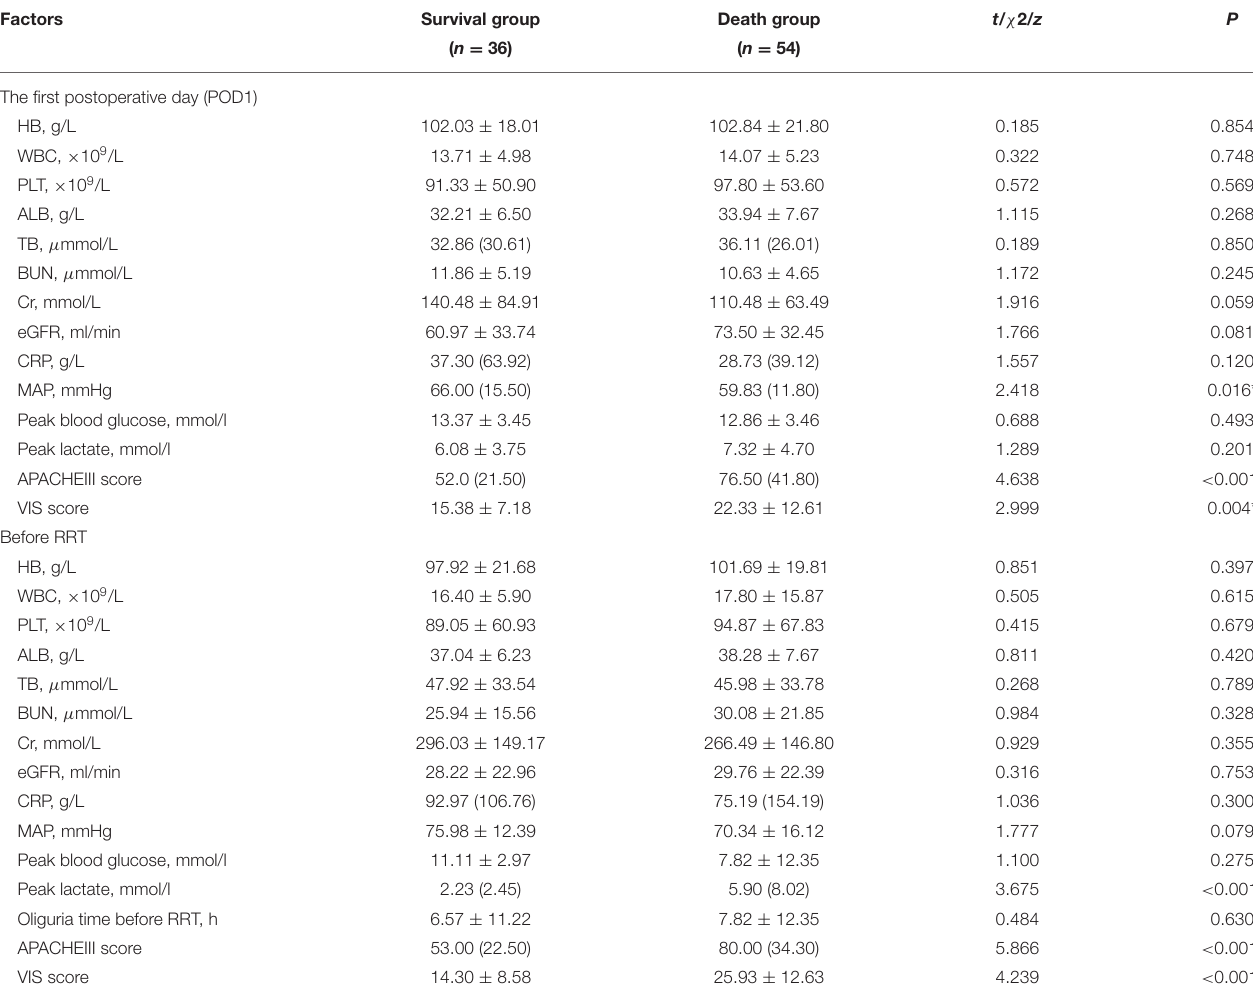
TABLE 2 | Clinical parameters on the first day after operation and before renal replacement therapy.